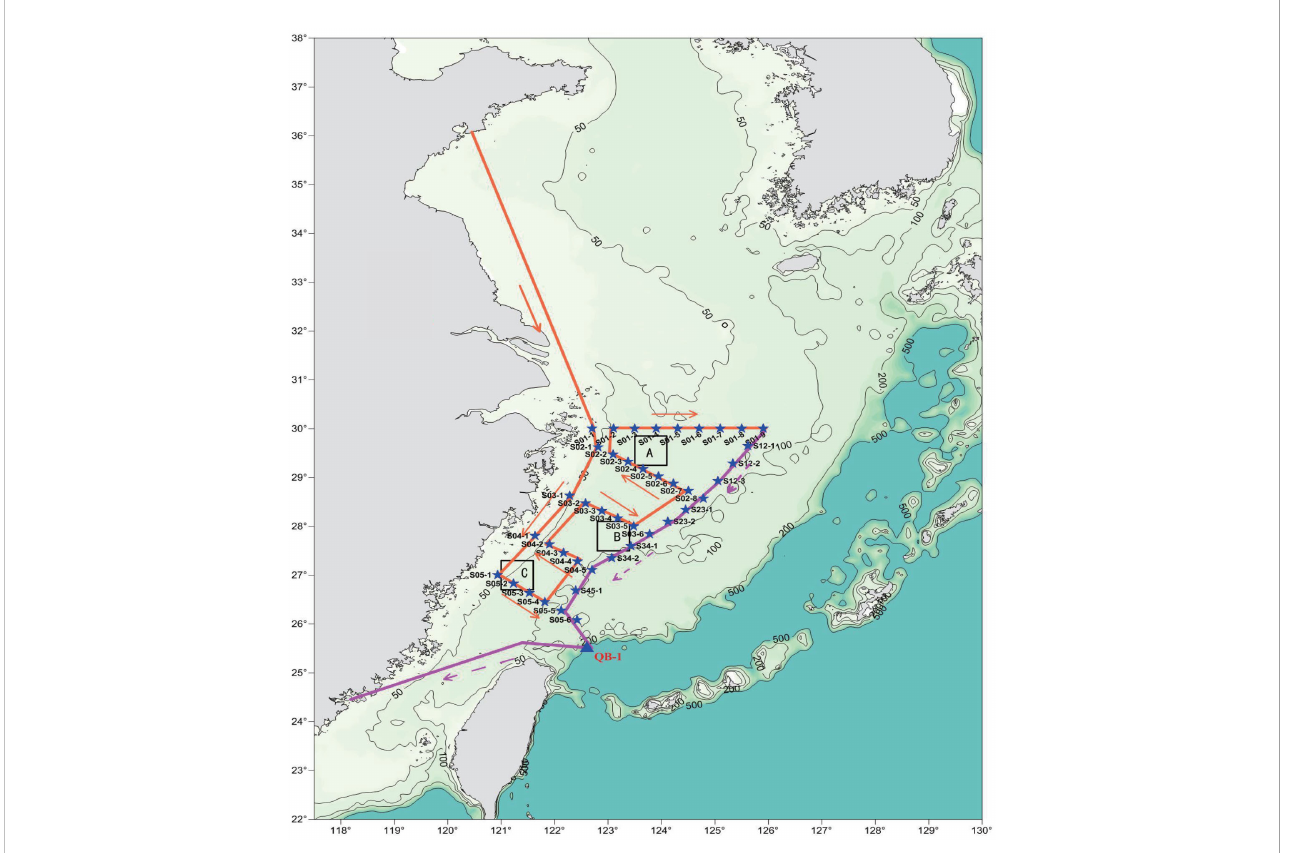
FIGURE 2 Station and route map of the voyage. Select three areas from north to south (areas A , B , and C in the fi gure), and the ship will sail back and forth in these